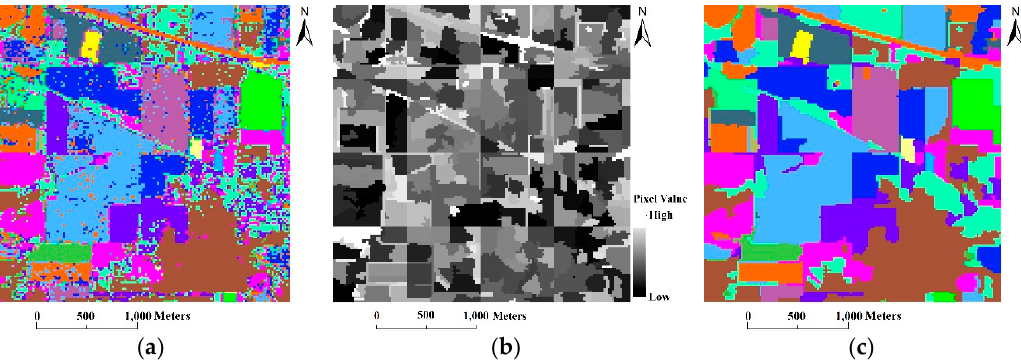
Figure 5. Spectral-spatial classification for the Indian Pines image using majority voting within segmentation regions: ( a ) the pixel-wise SVM classification map; ( b ) the AMG-derived M-HSEG segmentation map; and ( c ) the final classification map.